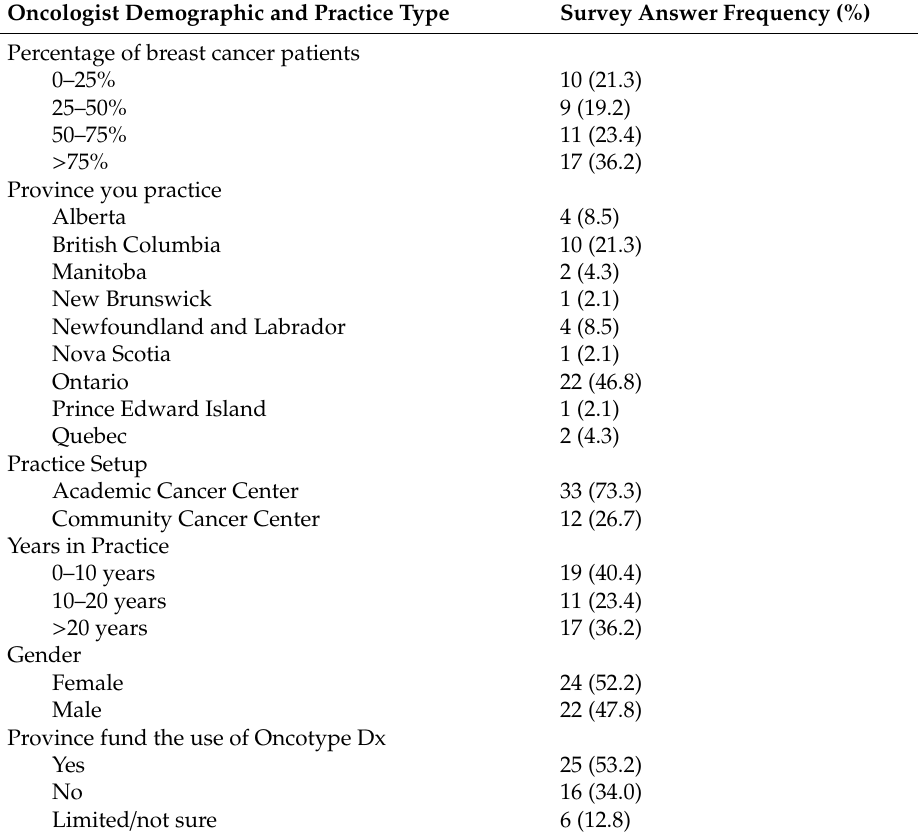
Table 1. Survey respondent demographic data.